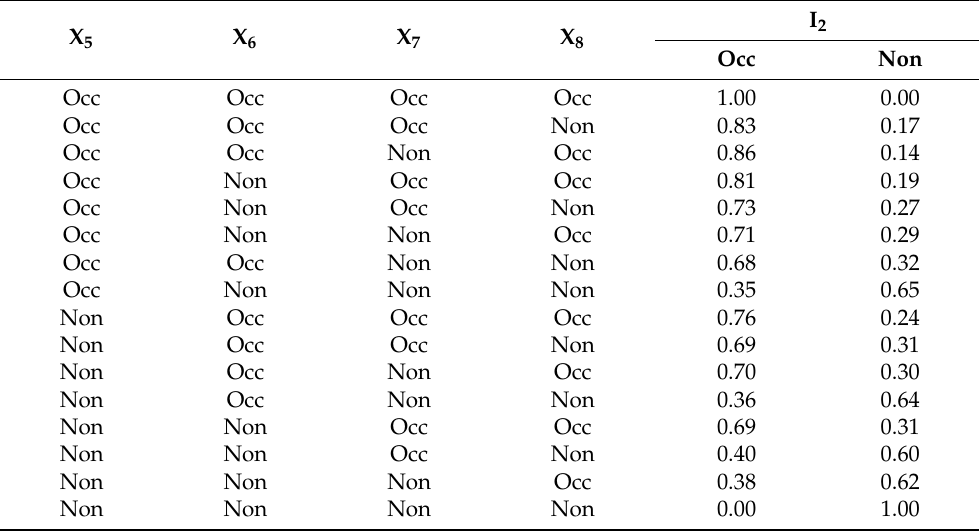
Table A1. The CPT of event I 2 (Abnormal liquid level; Occ: occurred; Non: non-occurred).